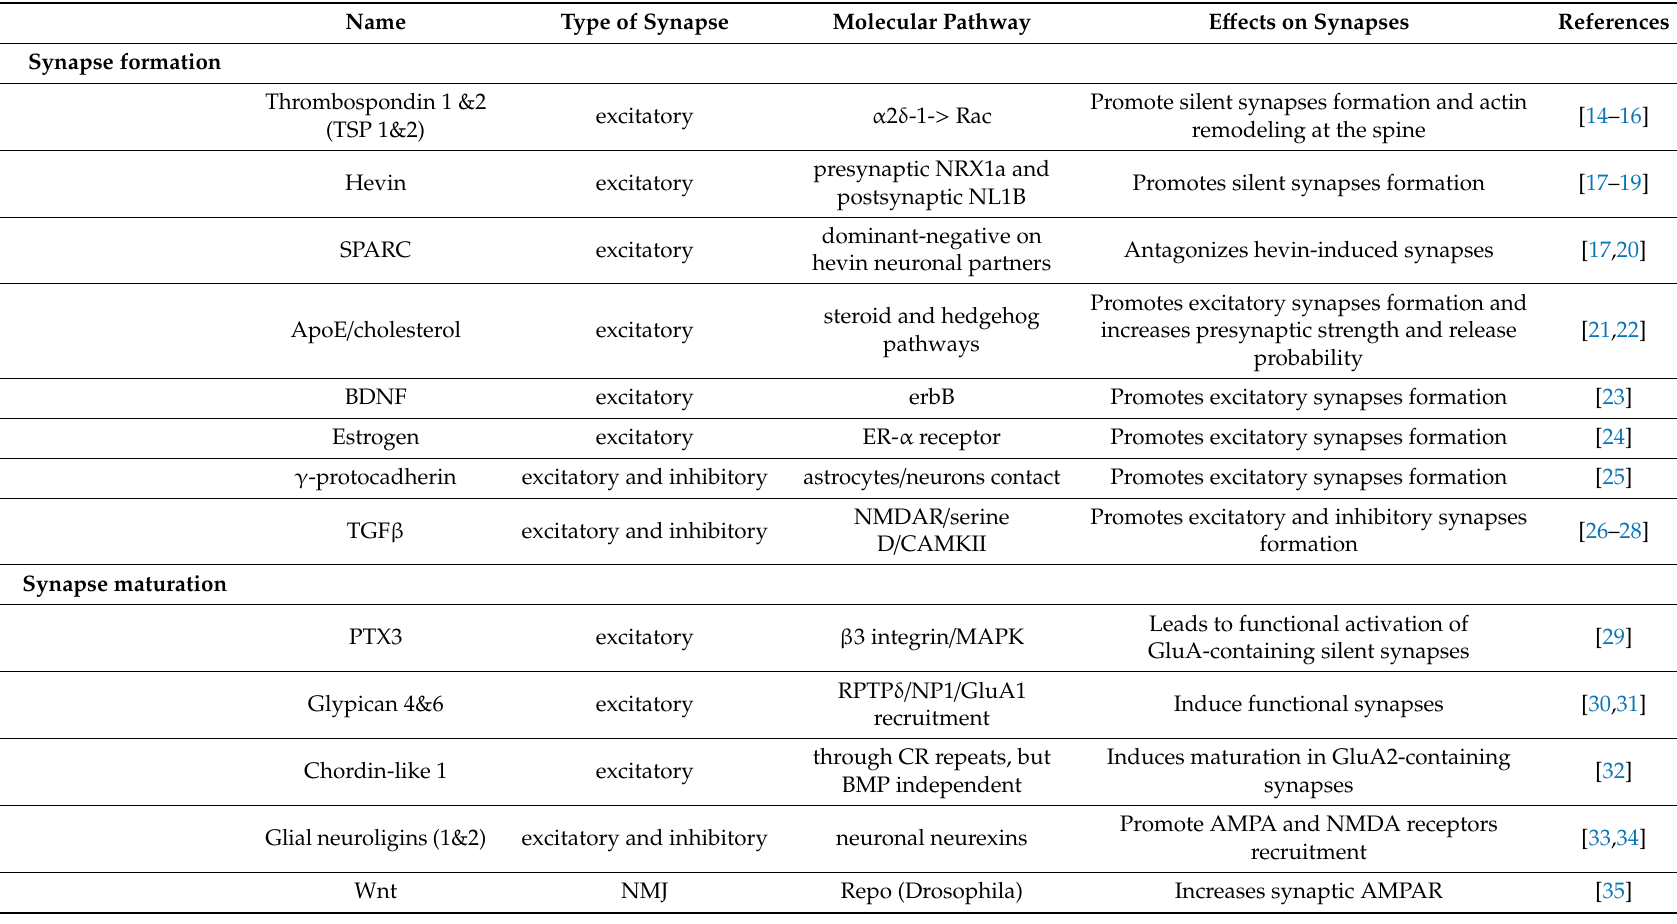
Table 1. Main synaptogenetic astrocyte-secreted